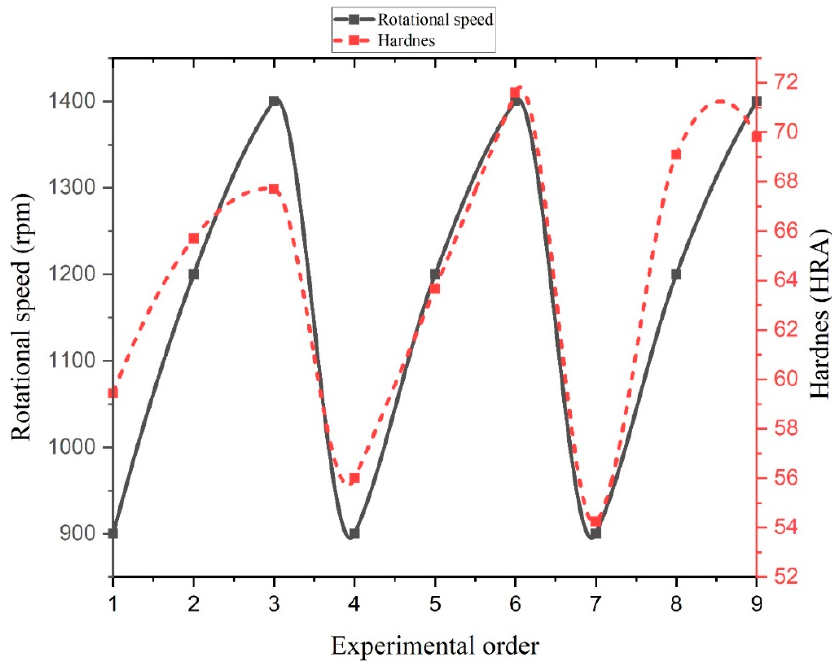
Figure 7. Effects of rotational speed on the hardness property of AA 6061.